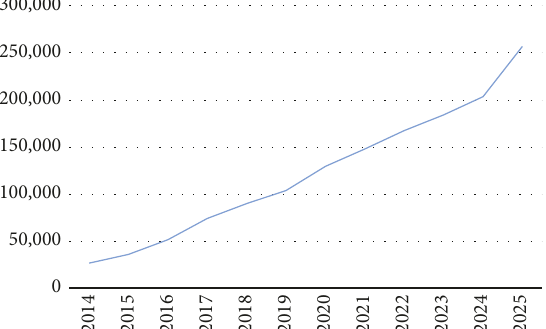
Figure 9: Solar energy supply in Italy by year, gigawatts per hour. Source: IEA; author’s calculations.